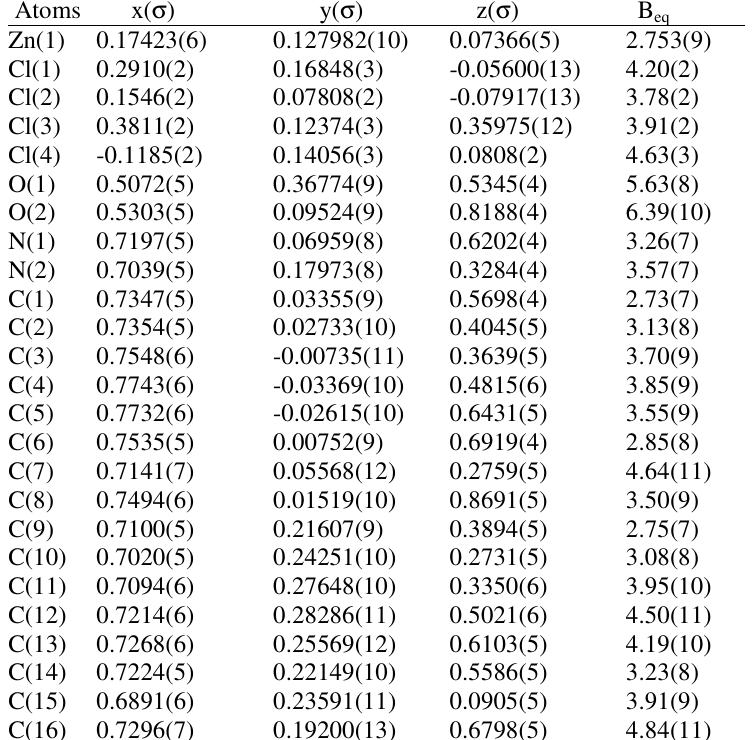
( Ǻ 2 ) of the non-hydrogen atoms of [2,6-(CH eq